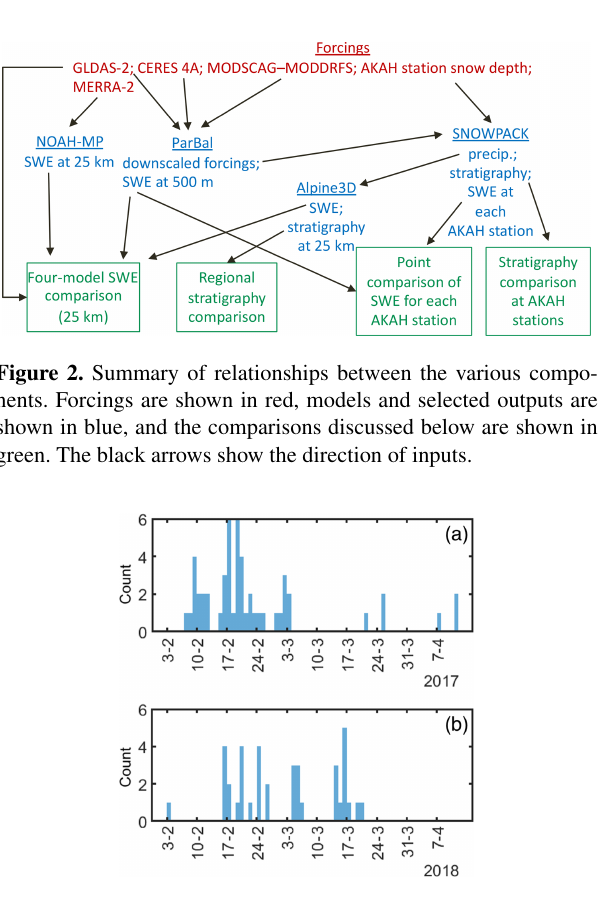
Figure 3. Peak SWE dates, modeled by SNOWPACK for 2017 (a) and 2018 (b) for each of the AKAH stations. The median peak SWE dates are 19 February 2017 and 26 February 2018. N = 52 and 41 AKAH stations used for 2017 and 2018.